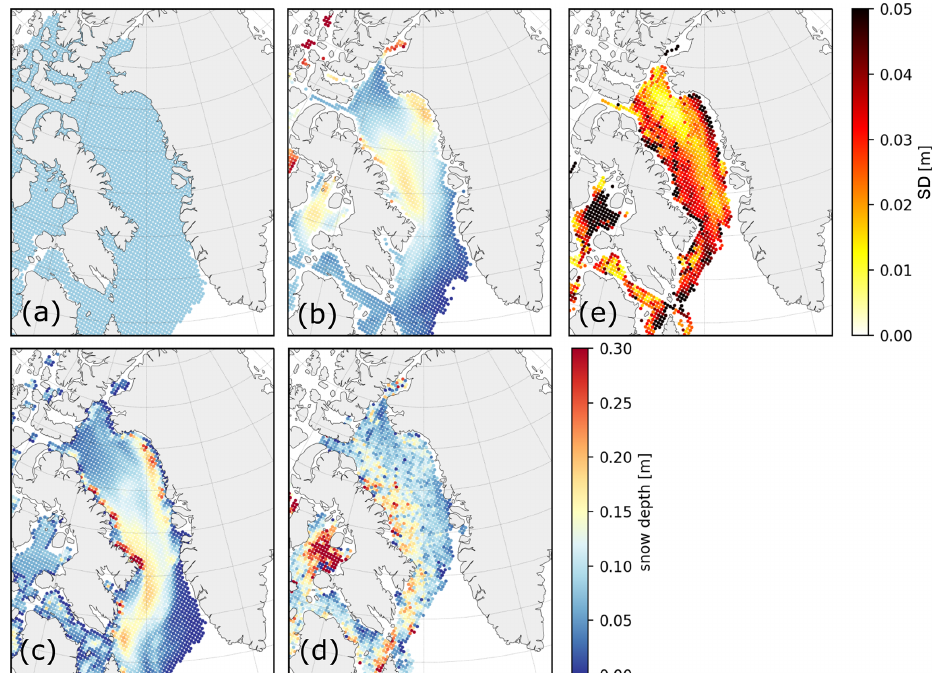
Figure 3. March mean of snow depth products. (a) W99 climatology (constant), (b) PMW snow depth product (2001–2020), (c) SnowModel- LG (2001–2020), (d) CryoSat-2/ICESat-2 product (2019–2020), and (e) the standard deviation between the different